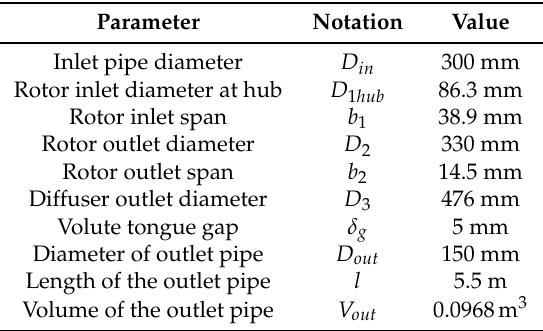
Table 1. Table of the most important dimensions of the test